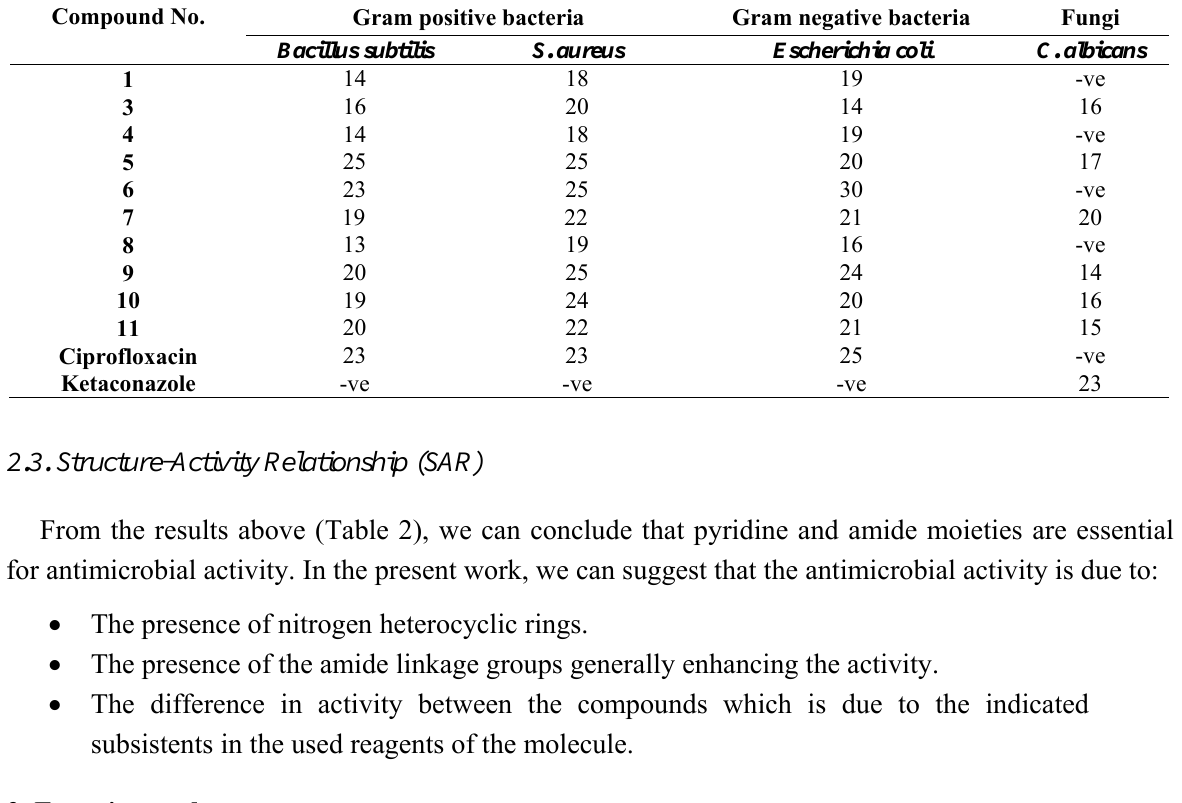
Table 2. Antimicrobial activities of the new synthesized compounds 3-11 . Compound